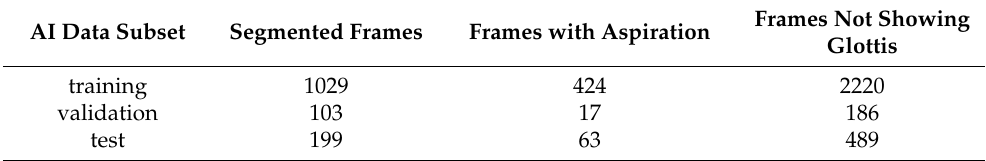
Table 1. Distribution of annotated frames across the different data sets.